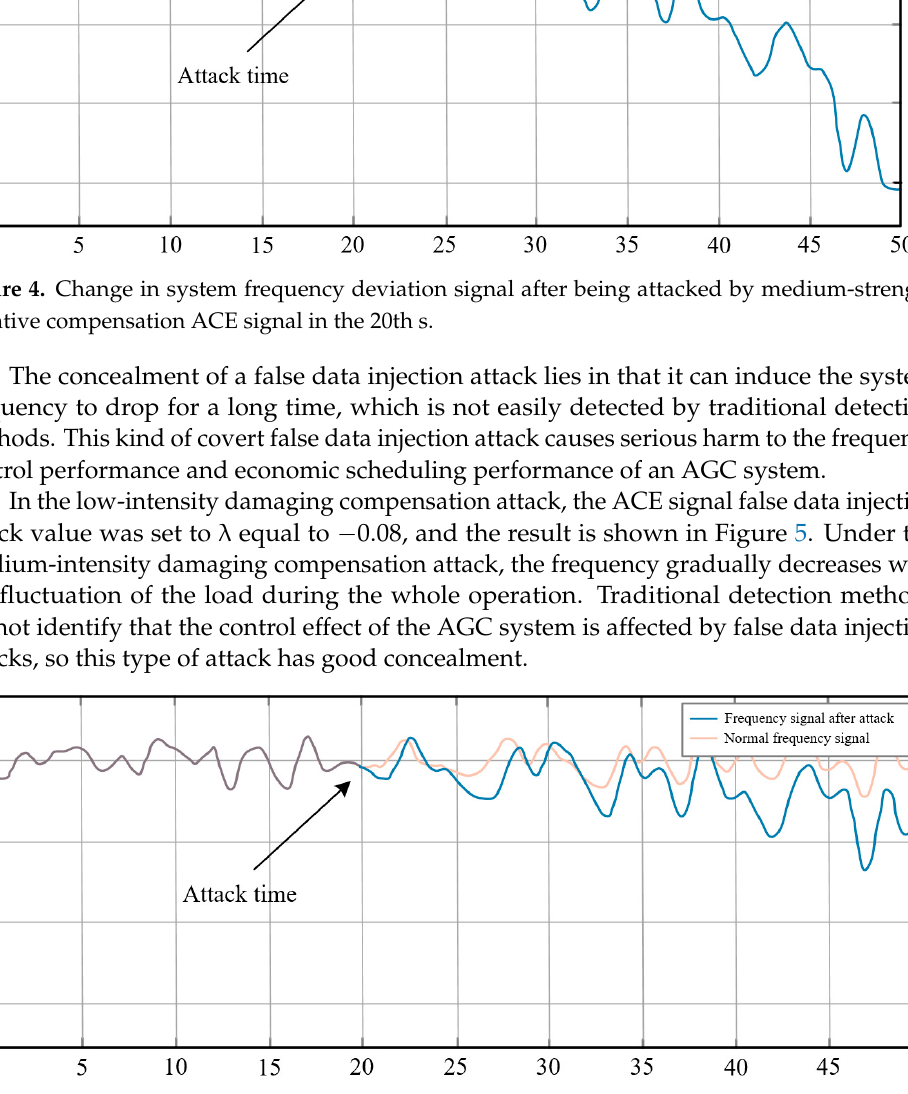
Figure 5. Change of system frequency deviation signal after being attacked by low-intensity nega- tive compensation ACE signal in the 20ths. compensation ACE signal in the 20th